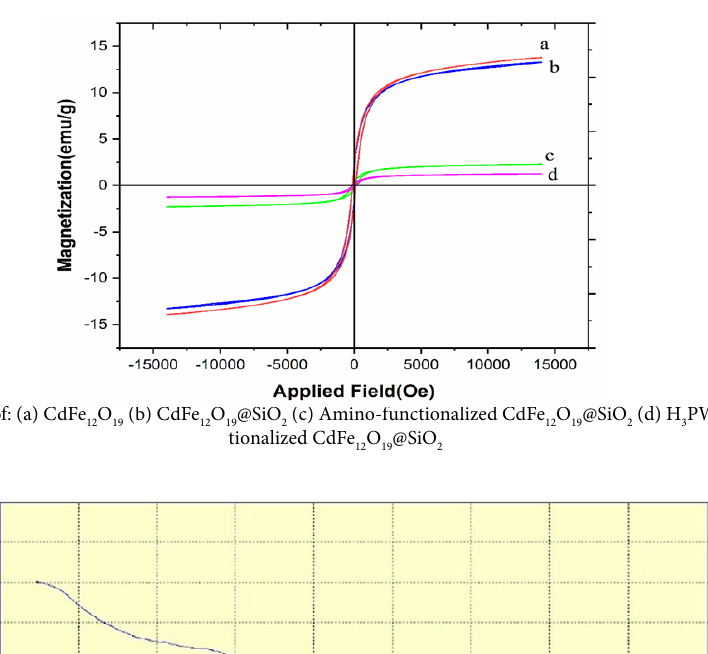
O (b) CdFe O @SiO (c) Amino-functionalized CdFe 12 19 12 19 2 CdFe Fig 3. FT-IR of (a) CdFe 12 O 19 (b) CdFe 12 O 19 @SiO 2 (c) Amino-functionalized CdFe 12 O 19 @SiO 2 (d) H 3 PW 12 O 40 - amino-functionalized CdFe 12 O 19 @SiO 2